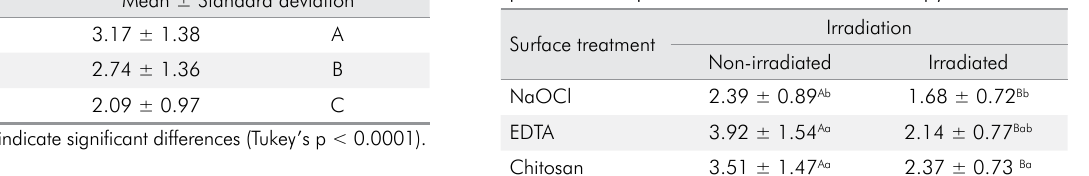
Table 3. Push-out bond strength means (in MPa) of the filling material to root dentin for the different surface treatments in specimens subjected or not to radiation therapy.